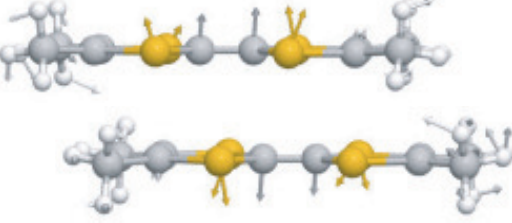
Figure 30. The Peierls-like mode of T character represents the vibrations of the TMTTF a molecules against each other; it is calculated at 82.3 cm − 1 using DFT method.